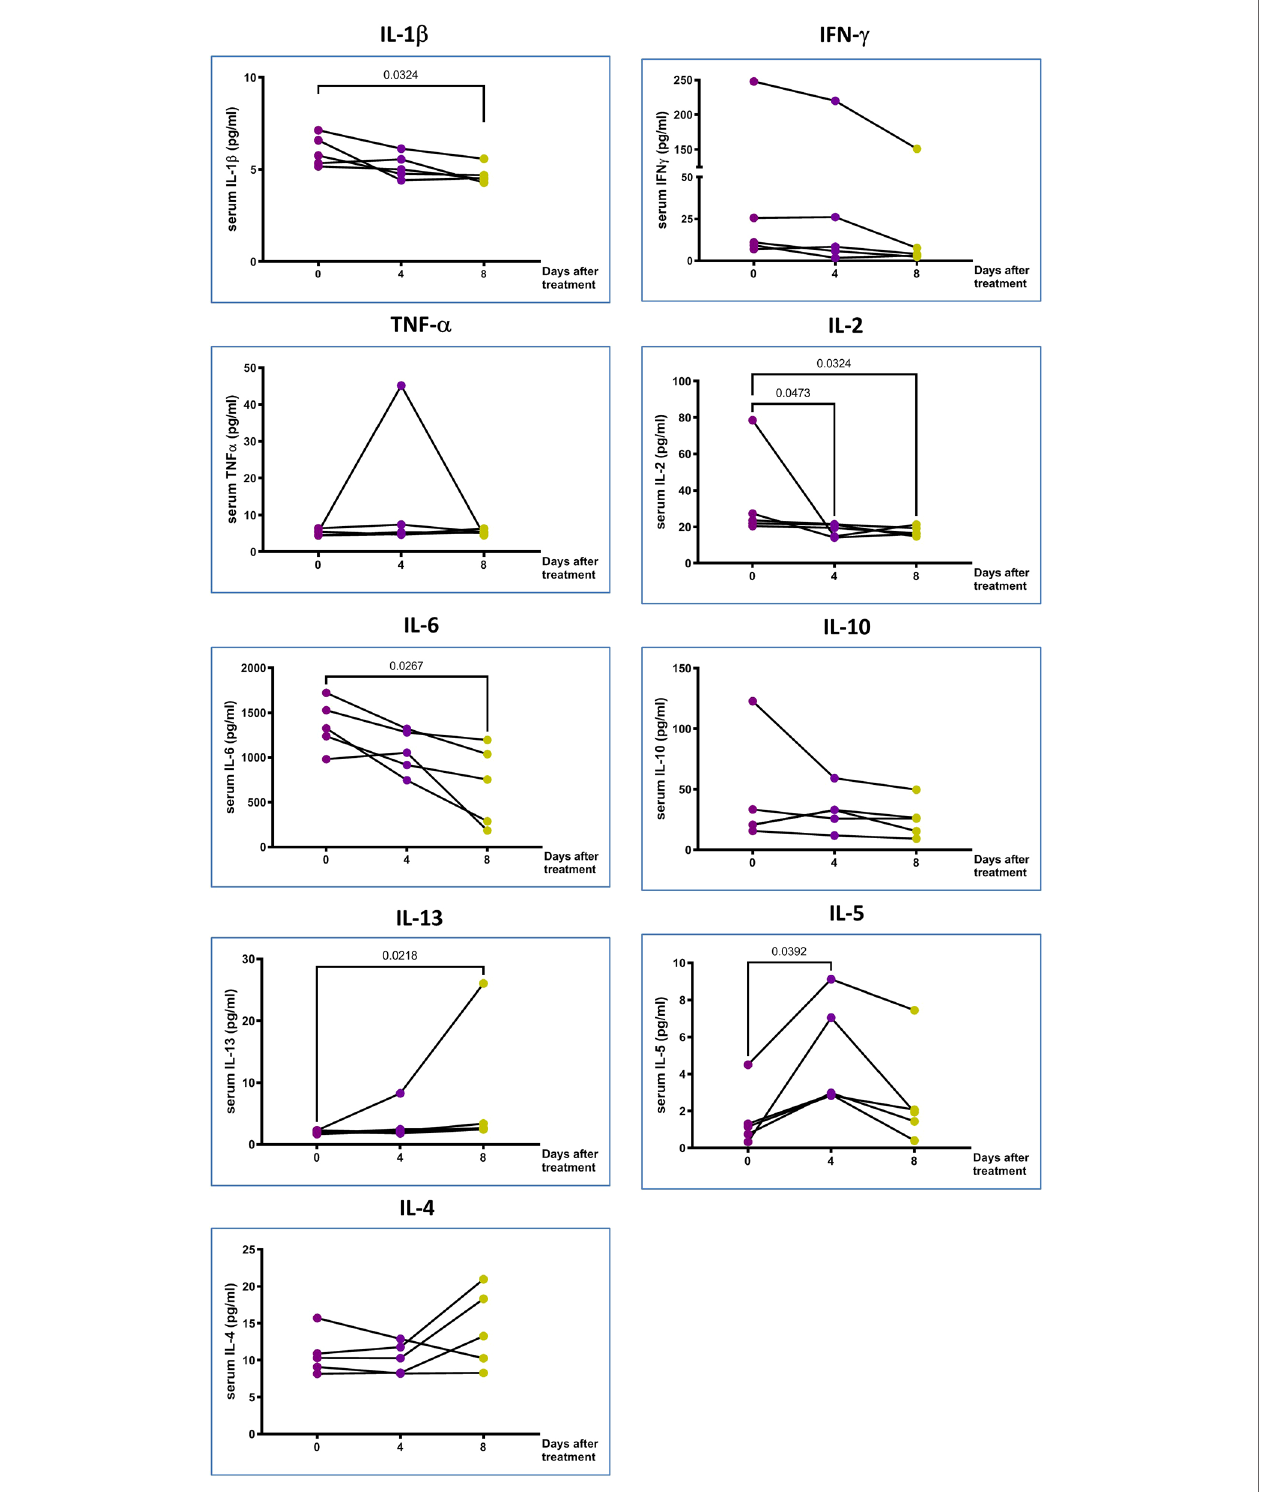
FIGURE 3 | The proin fl ammatory markers in the peripheral blood. IL-10 and type 2 cytokines changes of 5 treated patients in Days 0, 4 and 8 after pcMSCs therapy. The P value was as indicated. Nonparametric Wilcoxon sign-rank